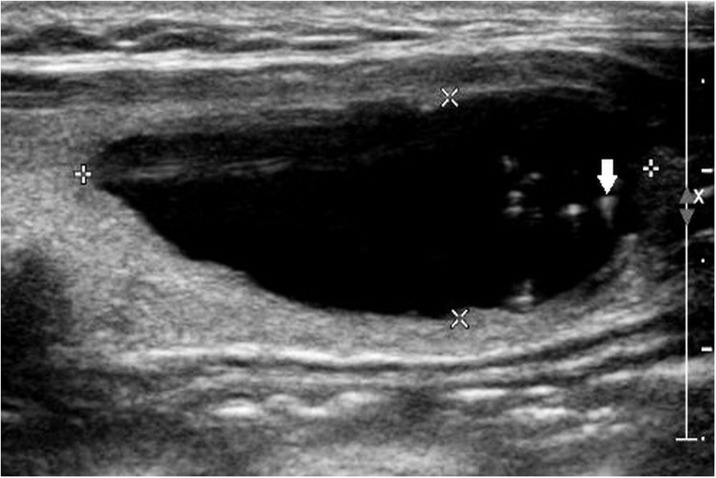
A 46-year-old woman with degenerated multinodular goiter.Longitudinal sonogram shows a 35 mm, smooth, cystic anechoic nodule in the left thyroid lobe. Echogenic foci with comet-tail artifact freely distributed (solid arrow) (Type 1). The patient underwent surgery due to contralateral thyroid malignancy.